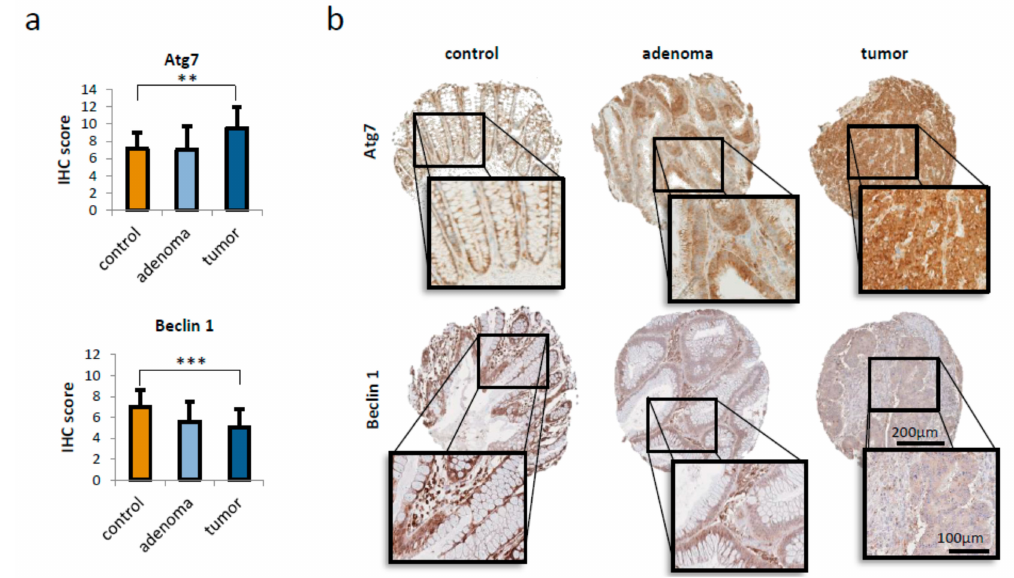
Figure 1. Autophagy regulation in colorectal carcinogenesis. ( a ) Relative expression of autophagy-associated proteins Atg7 and Beclin-1 in a tissue micro array (TMA) of non-matched human colon mucosa ( n = 10), adenoma ( n = 18) and carcinoma ( n = 49). Data represent mean + SD. ** = p < 0.01, *** = p < 0.001 ( b ) Representative images of Atg7 (upper panel) and Beclin-1 (lower panel) staining on control (mucosa), adenoma and adenocarcinoma TMA cores. Scale bars as